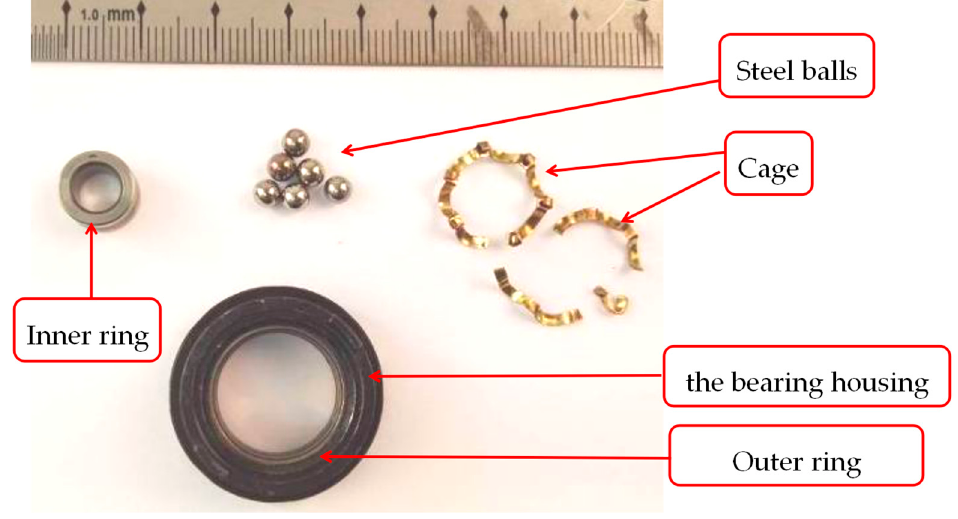
Figure 2. Appearance of the bearing and bearing housing. The damage appearance of the inner ring raceway is shown in Figure 3. There is obvious spalling along the whole circumferential area adjacent to the centrifugal block shaft of the inner ring raceway. The damaged area can be roughly divided into three parts: the first part is the severely damaged area, which accounts for about 3/4 of the width of the inner ring raceway; the second part is the lightly damaged area, which accounts for about 1 of the width of the inner ring raceway; and the third part is the least damaged area, which accounts for about 1 of the width of the inner ring raceway and is located at the interface 2 area between the severely damaged area and the lightly damaged area. There is